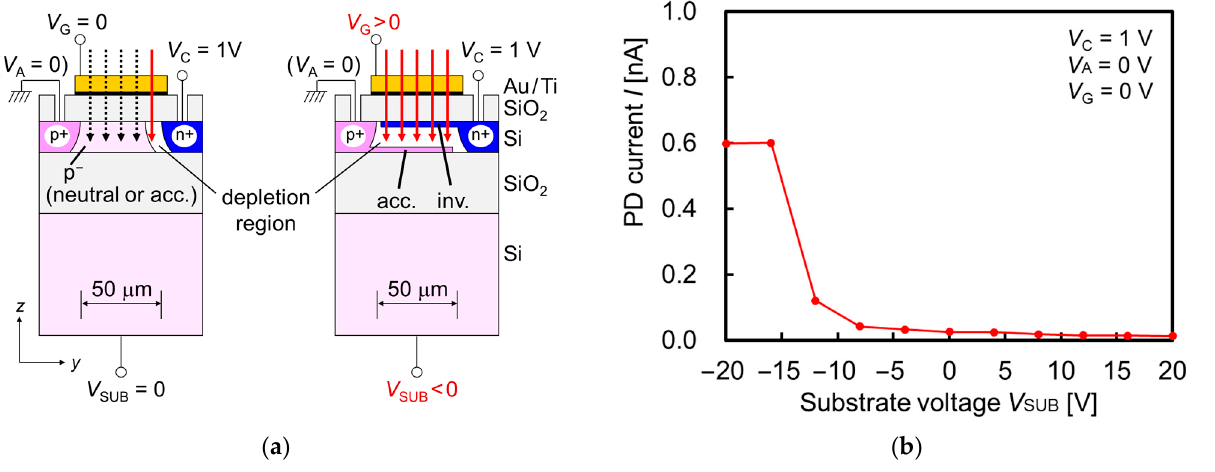
Figure 3. ( a ) Schematic models of different photocurrent depending on depletion region. Solid and dotted arrows indicate detectable and undetectable light rays, respectively, due to position and volume of depletion region. The “acc.” and “inv.” represent “accumulated” and “inverted”, respectively. ( b ) Measured photodiode (PD) current as a function of substrate voltage V SUB , when no bias voltage was applied to gate electrode ( V G = 0 V). Transverse magnetic (TM)-polarized light with the wavelength of 685 nm is irradiated normal to silicon-on-insulator (SOI) PD with surface plasmon (SP) antenna. The voltages of cathode and anode are fixed at V C = 1 V and V A = 0 V, respectively.